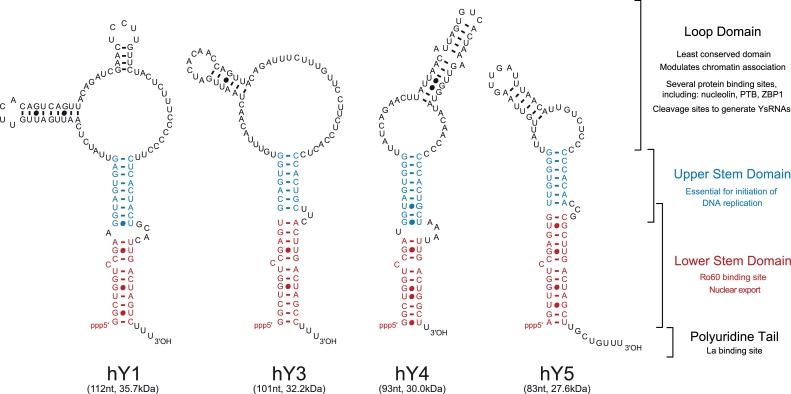
The non-coding human Y RNAs. The nucleotide sequences and secondary structures of hY RNAs are derived from sequence alignment and enzymatic and chemical probing (Teunissen et al., 2000, van Gelder et al., 1994). The conserved structural RNA domains and their associated functions are highlighted for each hY RNA. The size in nucleotides (nt) and molecular weight (kDa) of each RNA is indicated. See main text for references.